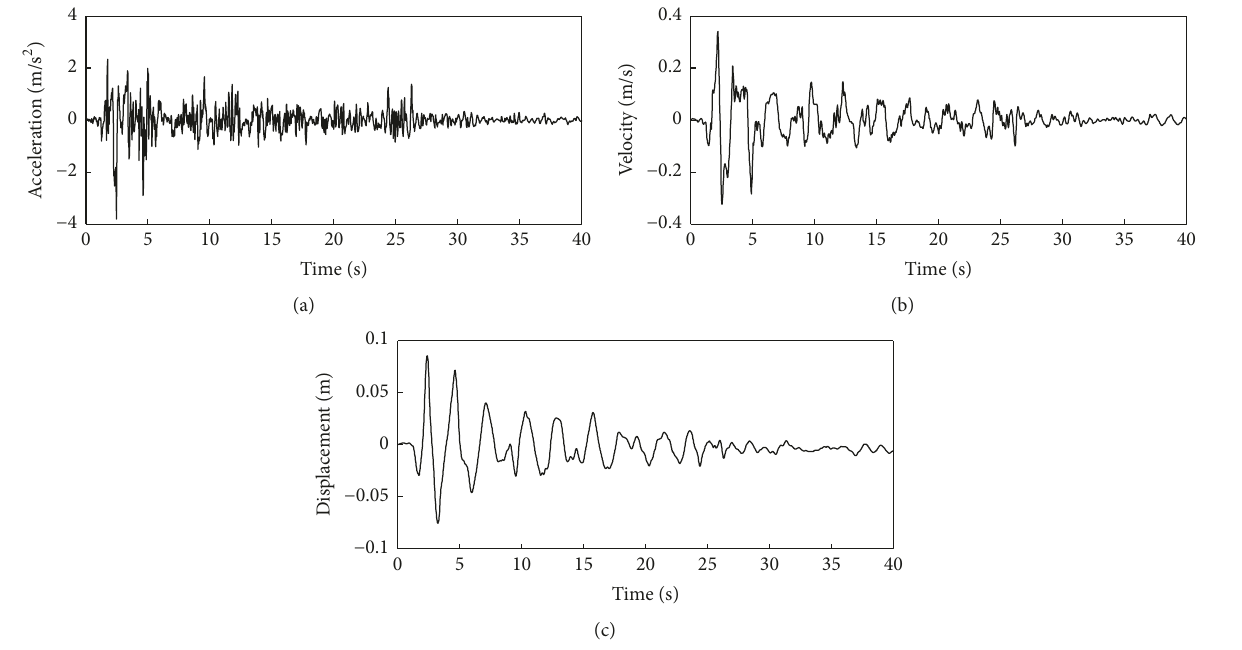
Figure 4: Simulated ground motion at station with 𝑟 𝑛 = 600 m: (a) acceleration; (b) velocity; (c) displacement.